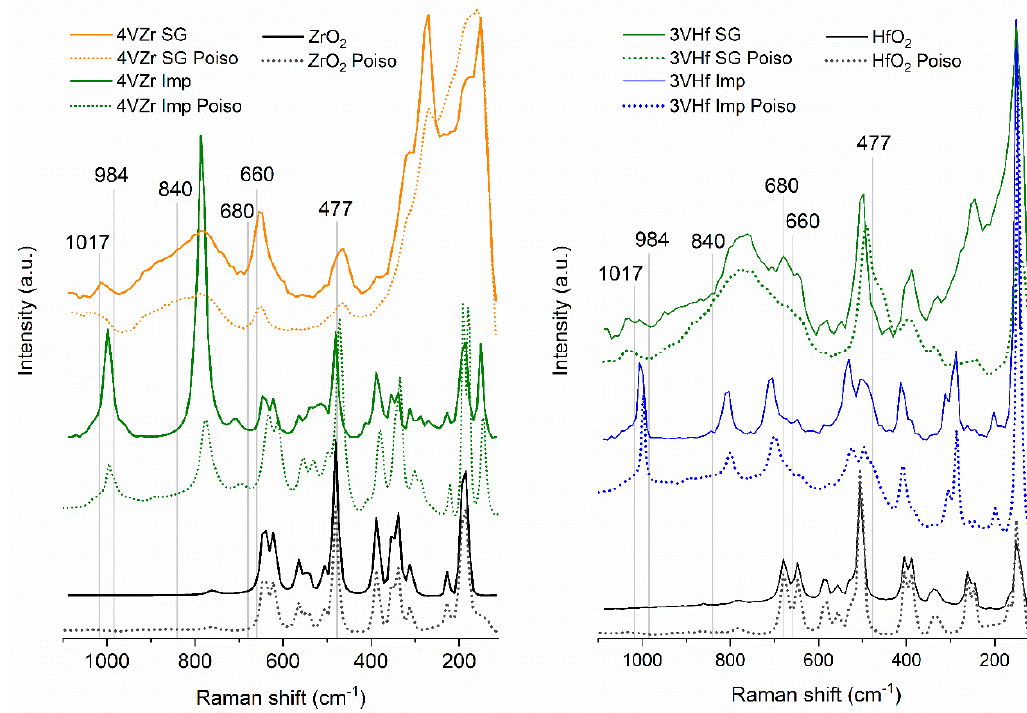
Figure 7. Raman spectra of the poisoned catalysts, HfO 2 and ZrO 2 , together with corresponding fresh materials.